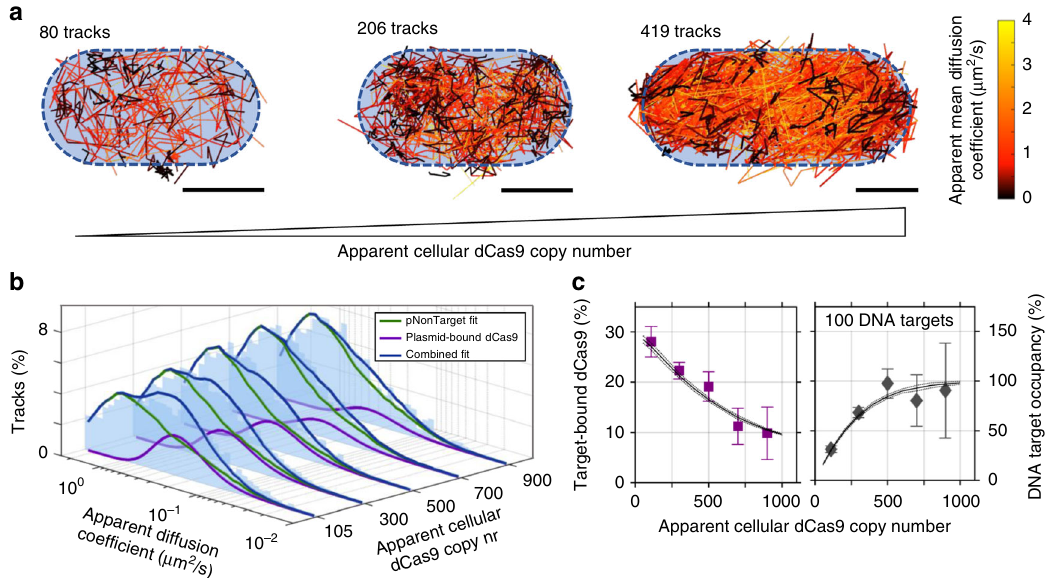
Fig. 3 sptPALM of dCas9-PAmCherry2 in pTarget L. lactis shows target-binding behaviour of dCas9. a Identi fi ed tracks in individual pTarget L. lactis cells. Tracks are colour-coded based on their diffusion coef fi cient. Three separate cells are shown with increasing dCas9 concentration. Blue dotted outline is an indication for the cell membrane. Scale bars represent 500 nm. b Diffusion coef fi cient histograms (light blue) are fi tted (dark blue line) with a combination of the respective fi t of pNonTarget L. lactis cells (green line), along with a single globally fi tted population corresponding to target-bound dCas9 (purple) at 0.38 ± 0.04 µ m 2 /s (mean ± standard deviation). c Left: The population size of the plasmid-bound dCas9 decreases as a function of the cellular dCas9 copy number. The error bar of the measurement is based on the 95% con fi dence interval determined by bootstrapping; the solid line is a model fi t with 20 plasmids, with a 95% con fi dence interval determined by repeating the model simulation. Right: Occupancy of DNA targets by dCas9 based on 20 target plasmids (100 DNA target sites), based on the same data as presented in the left fi gure. Source data are provided as a Source Data fi